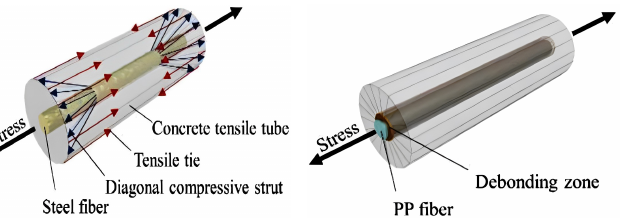
Figure 3. Matrix Interaction [85]. (Reprinted with permission from the publisher, Elsevier; License No.